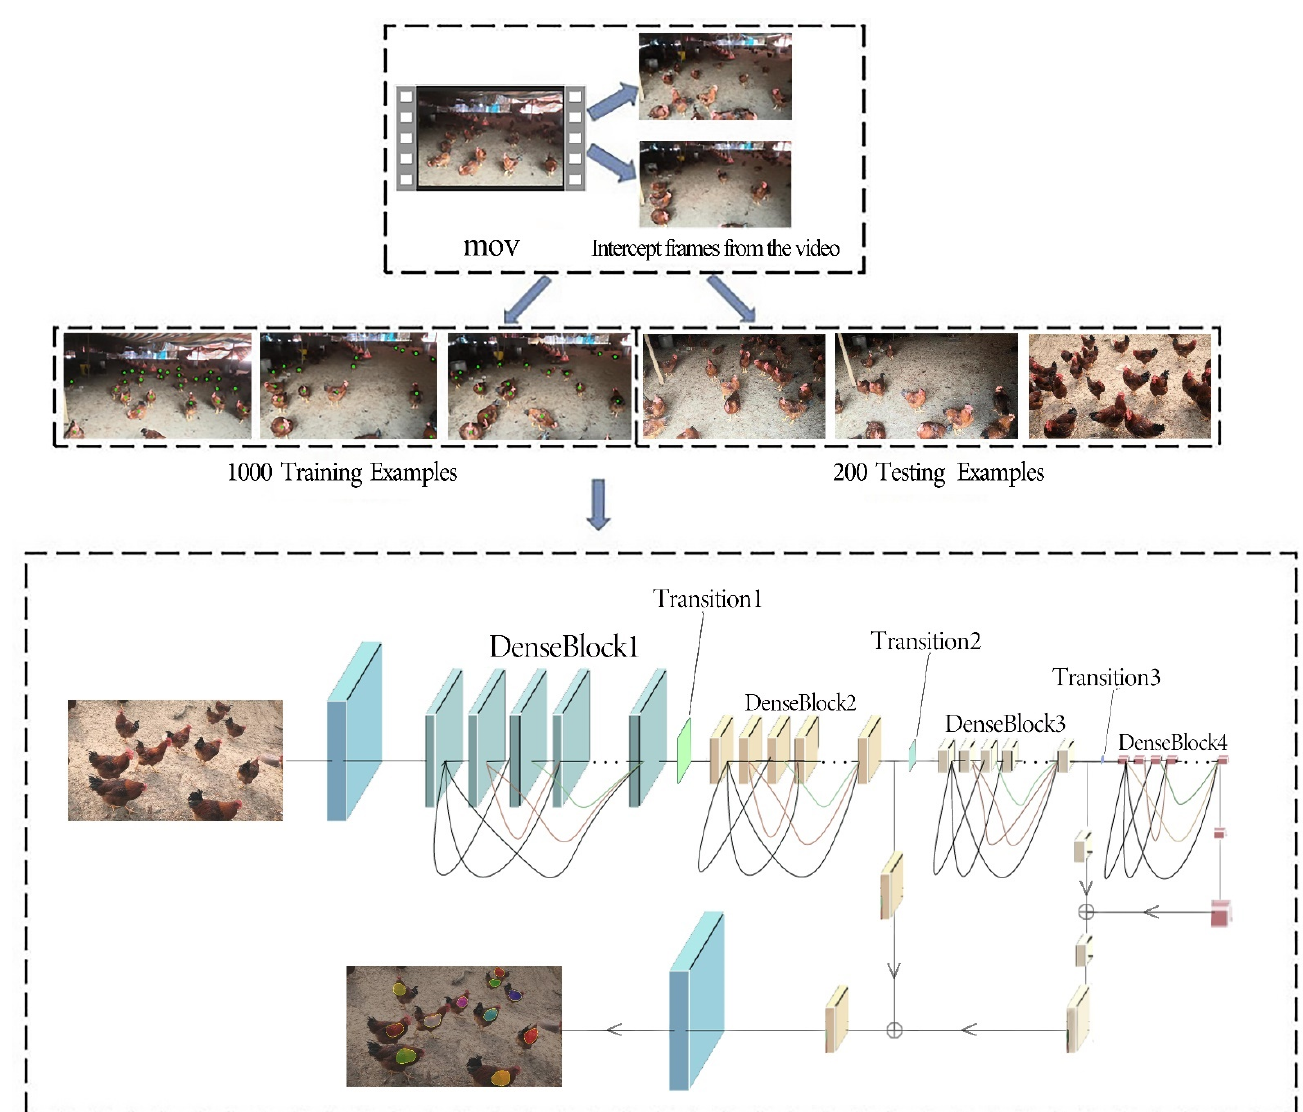
Figure 1. The structure of the chicken detection and counting